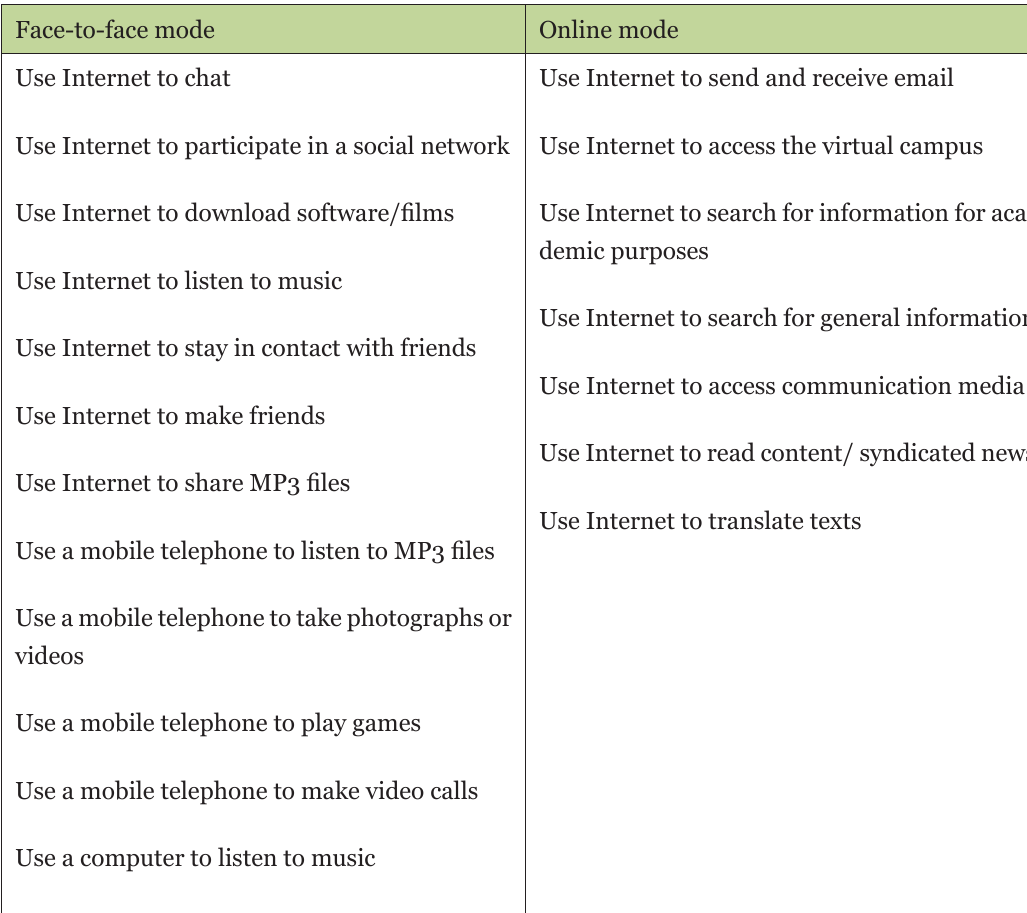
Informal Daily Use of ICT on Own Initiative Face-to-face